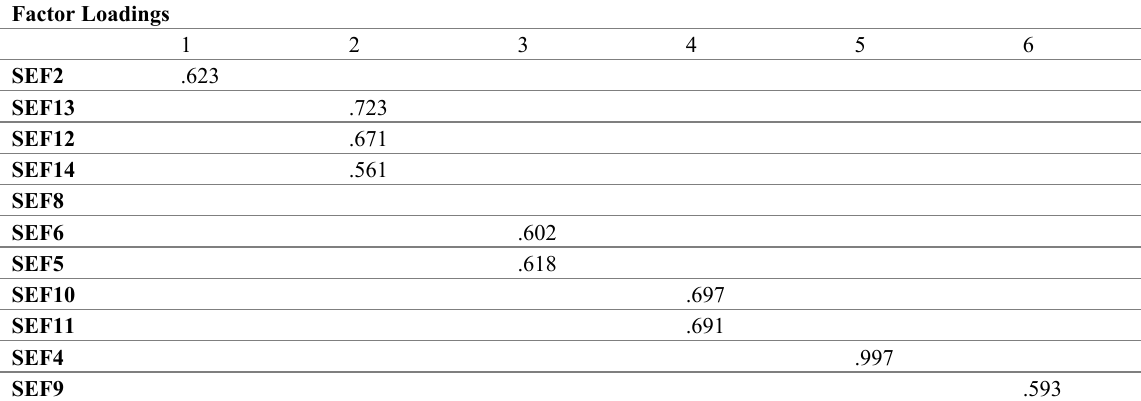
Table 5 : Cross Loadings for the Measurement